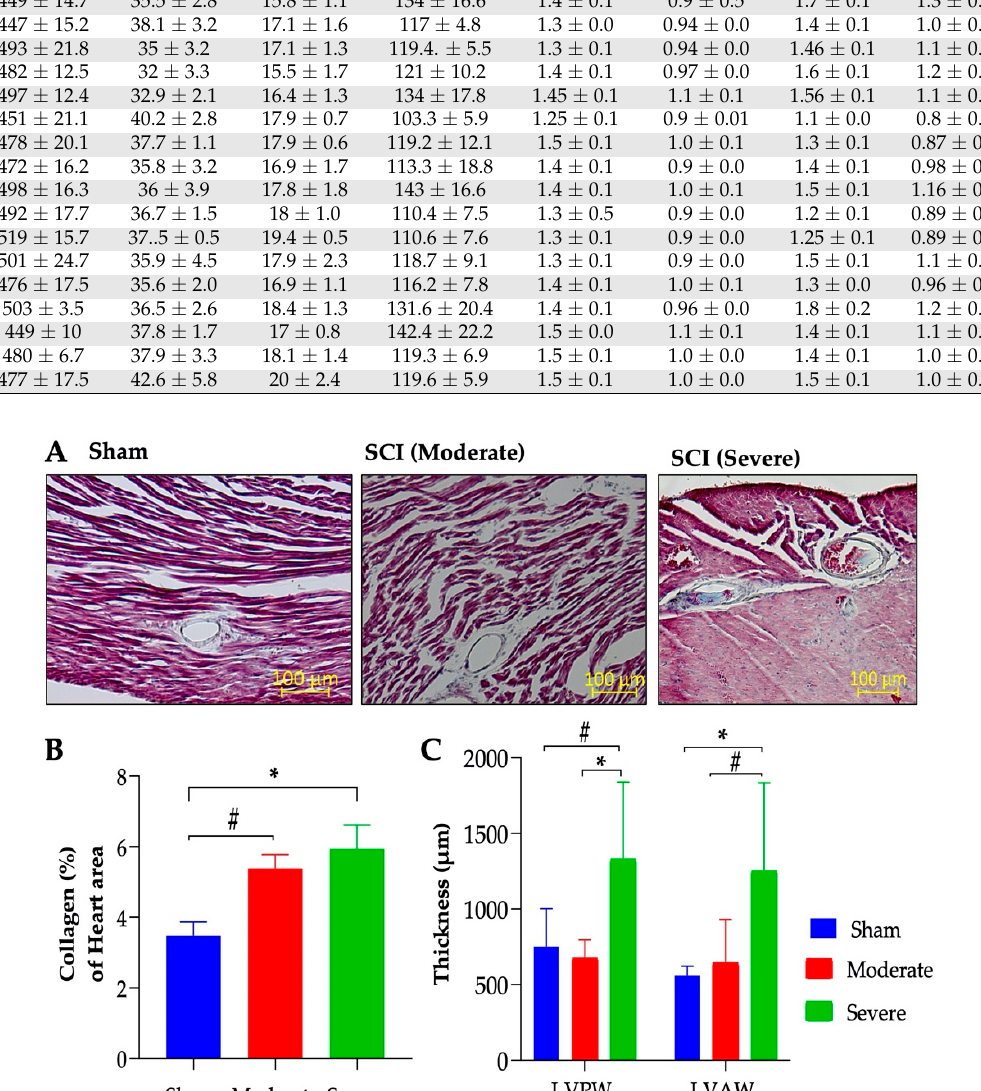
Figure 6. Injury-severity dependent increase in cardiac remodeling. ( A ) Representative 40 × sec- tions of Masson’s trichrome of sham, moderate-SCI, and severe-SCI after 20 weeks PI. ( B ) Quantifi- cation of collagen contents (blue) in the LV tissue. SCI significantly increased fibrotic tissue in the severe injured group and there is a trend to increase in the moderate group compared to the sham control. ( C ). LVPW and LVAW thickness. Scale bar = 100 µm. Values presented as mean ± S.E.M of 3–4 sections/mouse; n = 6 (sham), 8 (moderate), and 5–9 (severe). Data analyzed by ANOVA. * p < 0.05 and # p < 0.1.